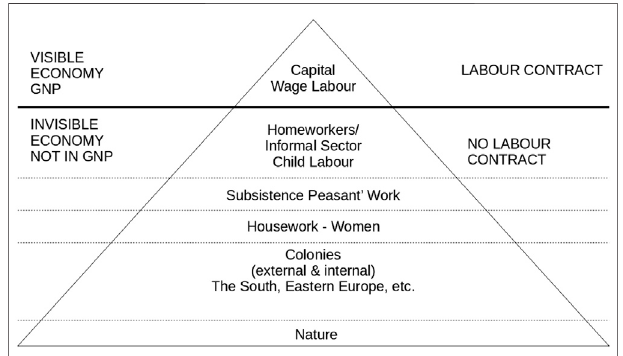
FIGURE 4 | The Iceberg Model of Captitalist Patriarchal Economics (Mies & Bennhold-Thomsen